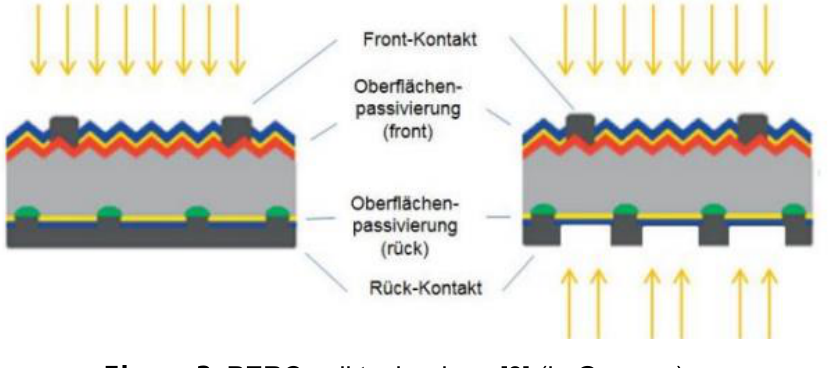
Figure 3. PERC cell technology [8] (in